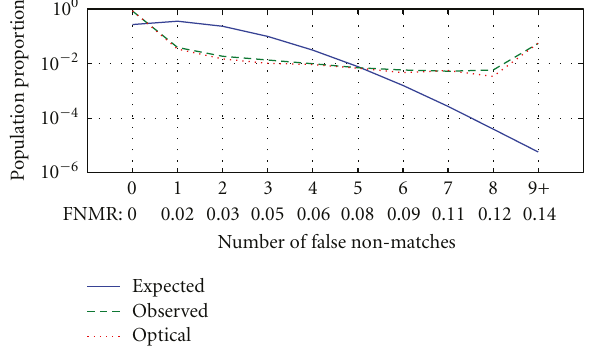
Figure 3: Distribution of expected (solid lines) and observed (dotted and dashed lines) number of false nonmatches across subjects for the capacitive sensor (dashed line) and the optical sensor (dotted line) based on a threshold to result in a mean FNMR of